Question: Describe this figure in one sentence.
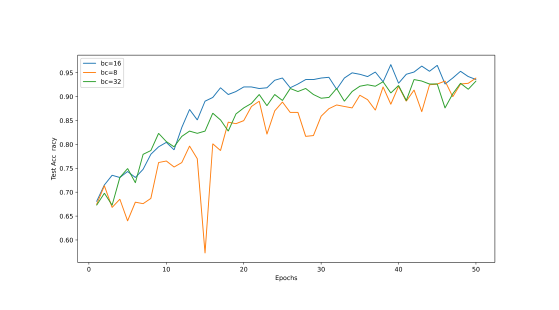
Answer: Accuracy at different batch sizes.